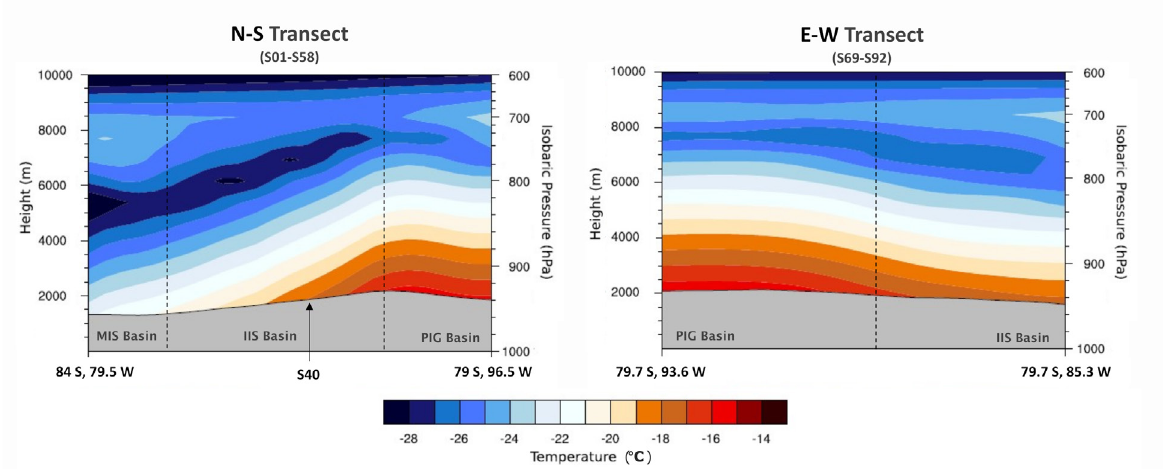
Figure 6. Annual mean temperature of the troposphere along the 2014 N-S (on the left) and E-W (on the right) transects. Temperature per height data were extracted from ERA 5 datasets. We emphasize that these temperatures can be interpreted only in relative